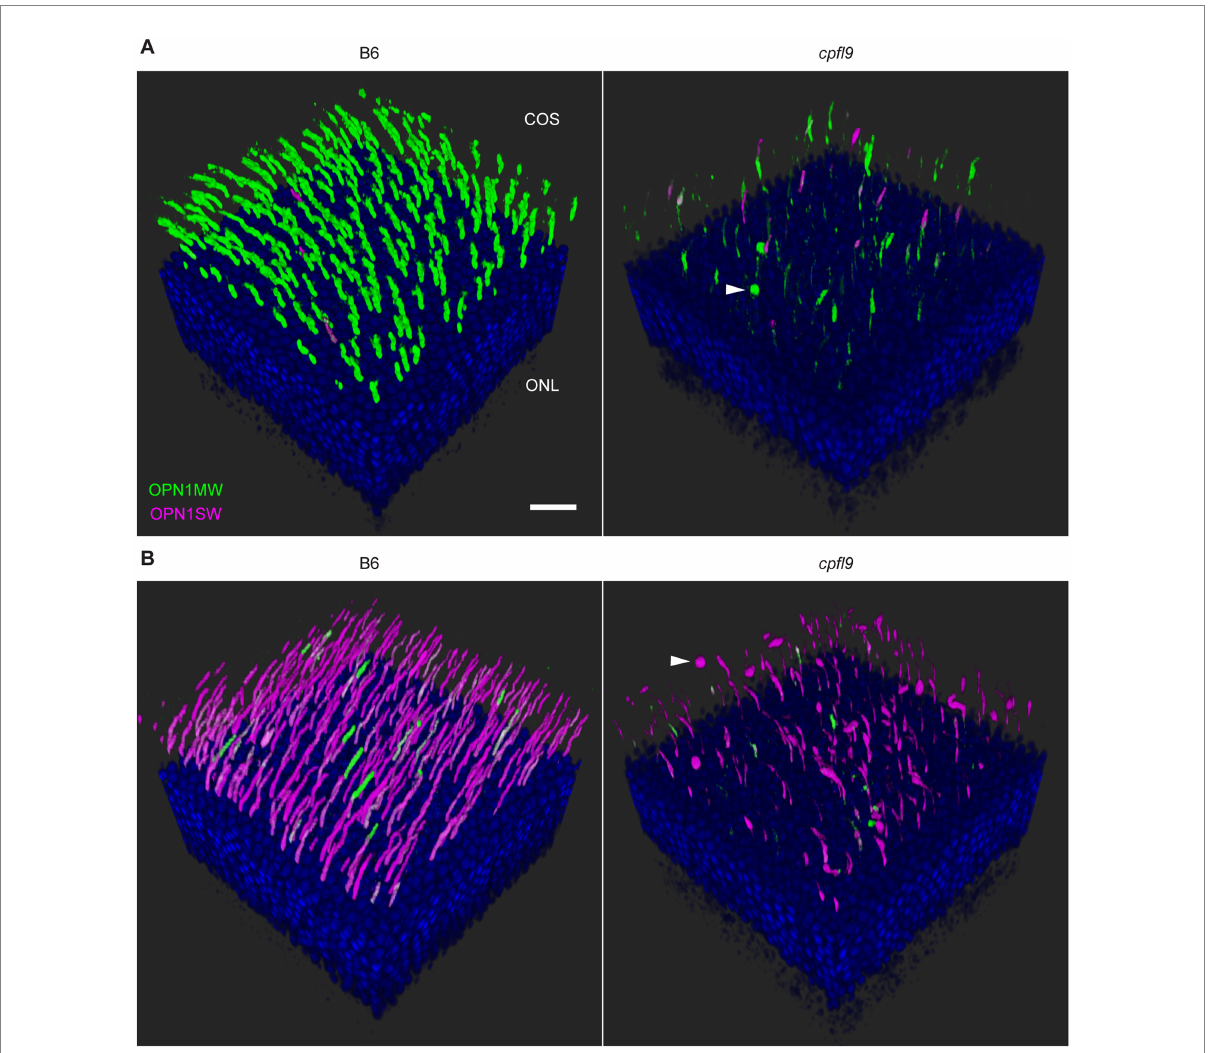
FIGURE 5 Confocal imaging of retinal flatmounts. B6 and cpfl9 flatmount samples prepared at 12 weeks of age were stained with cone opsin antibodies and PNA as in Figure 4. (A) Dorsal retina. Cone OS (COS) were OPN1MW-positive (green) except for a few OS that were partly or completely OPN1SW- positive (magenta). OPN1MW staining was substantially reduced in the cpfl9 retina. Round OPN1MW-positive objects were occasionally noted in the outermost retina (arrowhead). The ONL was revealed by DAPI staining (blue). Scale bar, 20 μ m. (B) Ventral retina. OPN1SW-positive cones were observed in the ventral retina of B6 mice except for occasional cones that also were partly positive for OPN1MW. Reduced staining of both opsins was observed in the cpfl9 ventral retina and round OPN1SW-positive objects were occasionally noted. Pseudocolors, symbols, and scale are the same as in panel A . Images are representative of n = 4 cpfl9 and n = 5 B6